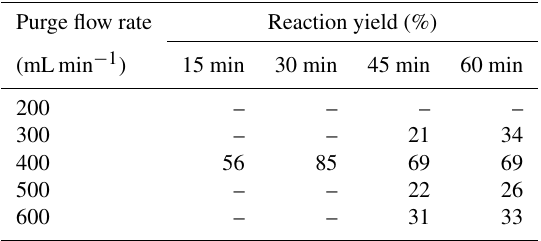
Table 2. Reaction yields of the reaction of DAN with NO at differ- ent flow rates and purge